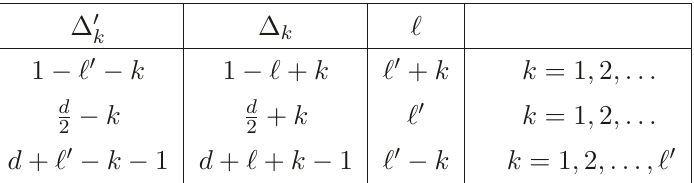
Table 1 . Solutions of the algebraic system (2.12). The first column lists the position of the poles of a generic conformal block G a,b ∆ ′ . The second and third columns list the scaling dimension ∆ k ,ℓ ′ and the spin ℓ of the conformal block contributing to the residue in